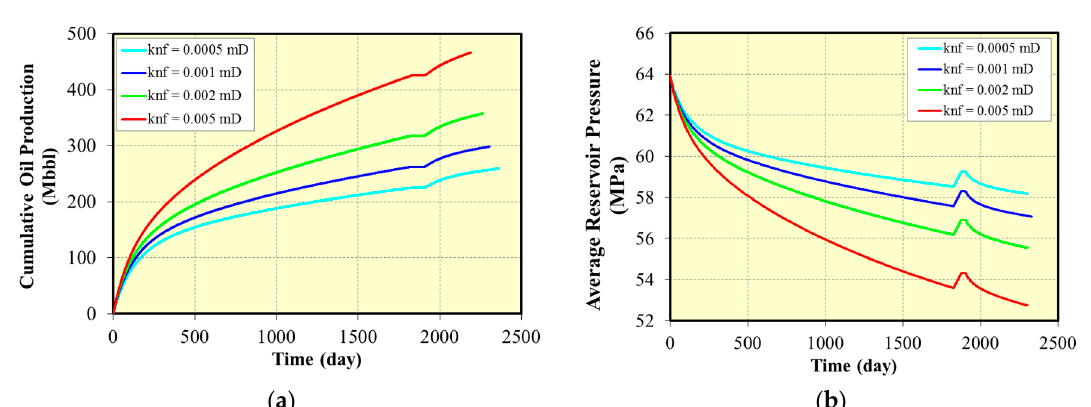
Figure 15. Effect of different natural fracture permeability with one huff-n-puff cycle on oil production and reservoir pressure: ( a ) Cumulative oil production for different natural fracture permeability; ( b ) Average reservoir pressure for different natural fracture permeability.